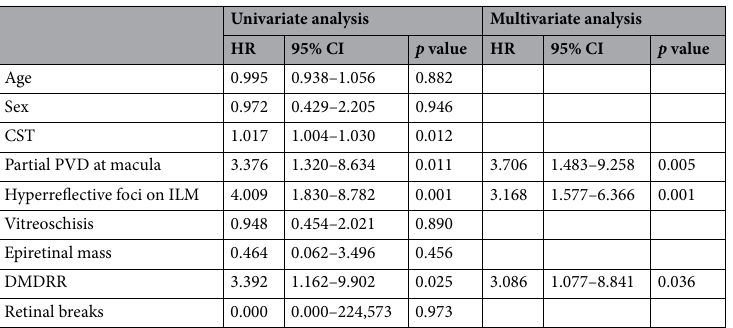
Table 4. Cox Proportional Hazard Model for prediction of ERM onset after cataract surgery in eyes without ERM at baseline (n = 663). CST central subfoveal thickness, DMDRR discrete margin of different retinal reflectivity, ERM epiretinal membrane, ILM internal limiting membrane, PSD pachychoroid spectrum disease, PVD posterior vitreous detachment, VMI vitreomacular interface.